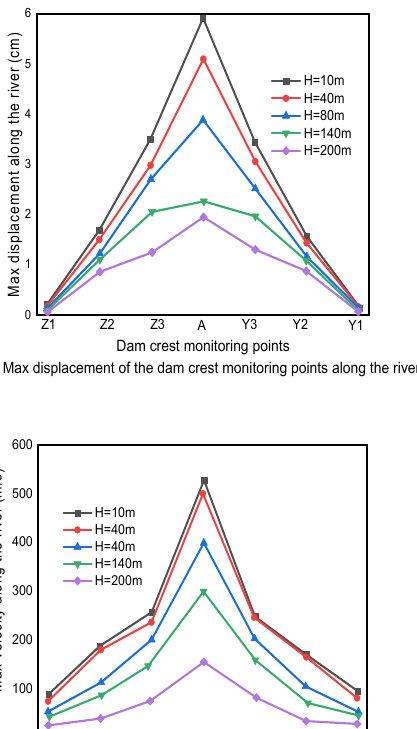
Figure 15. Dam crest damage curves for various blasting depths. The maximum values of displacement, velocity, and acceleration of each monitoring point at the dam crest and arch crown cantilever in the entire dynamic time history are extracted to further investigate the dynamic response of the dam body under different detonation depths, as shown in Figure 16, where H stands for the detonation depth.